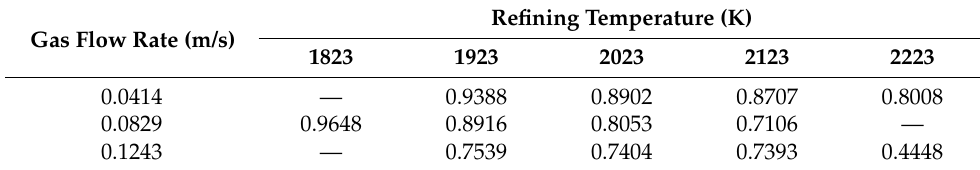
Table 2. Phosphorus content in refined 600MPa steel (mg/L).